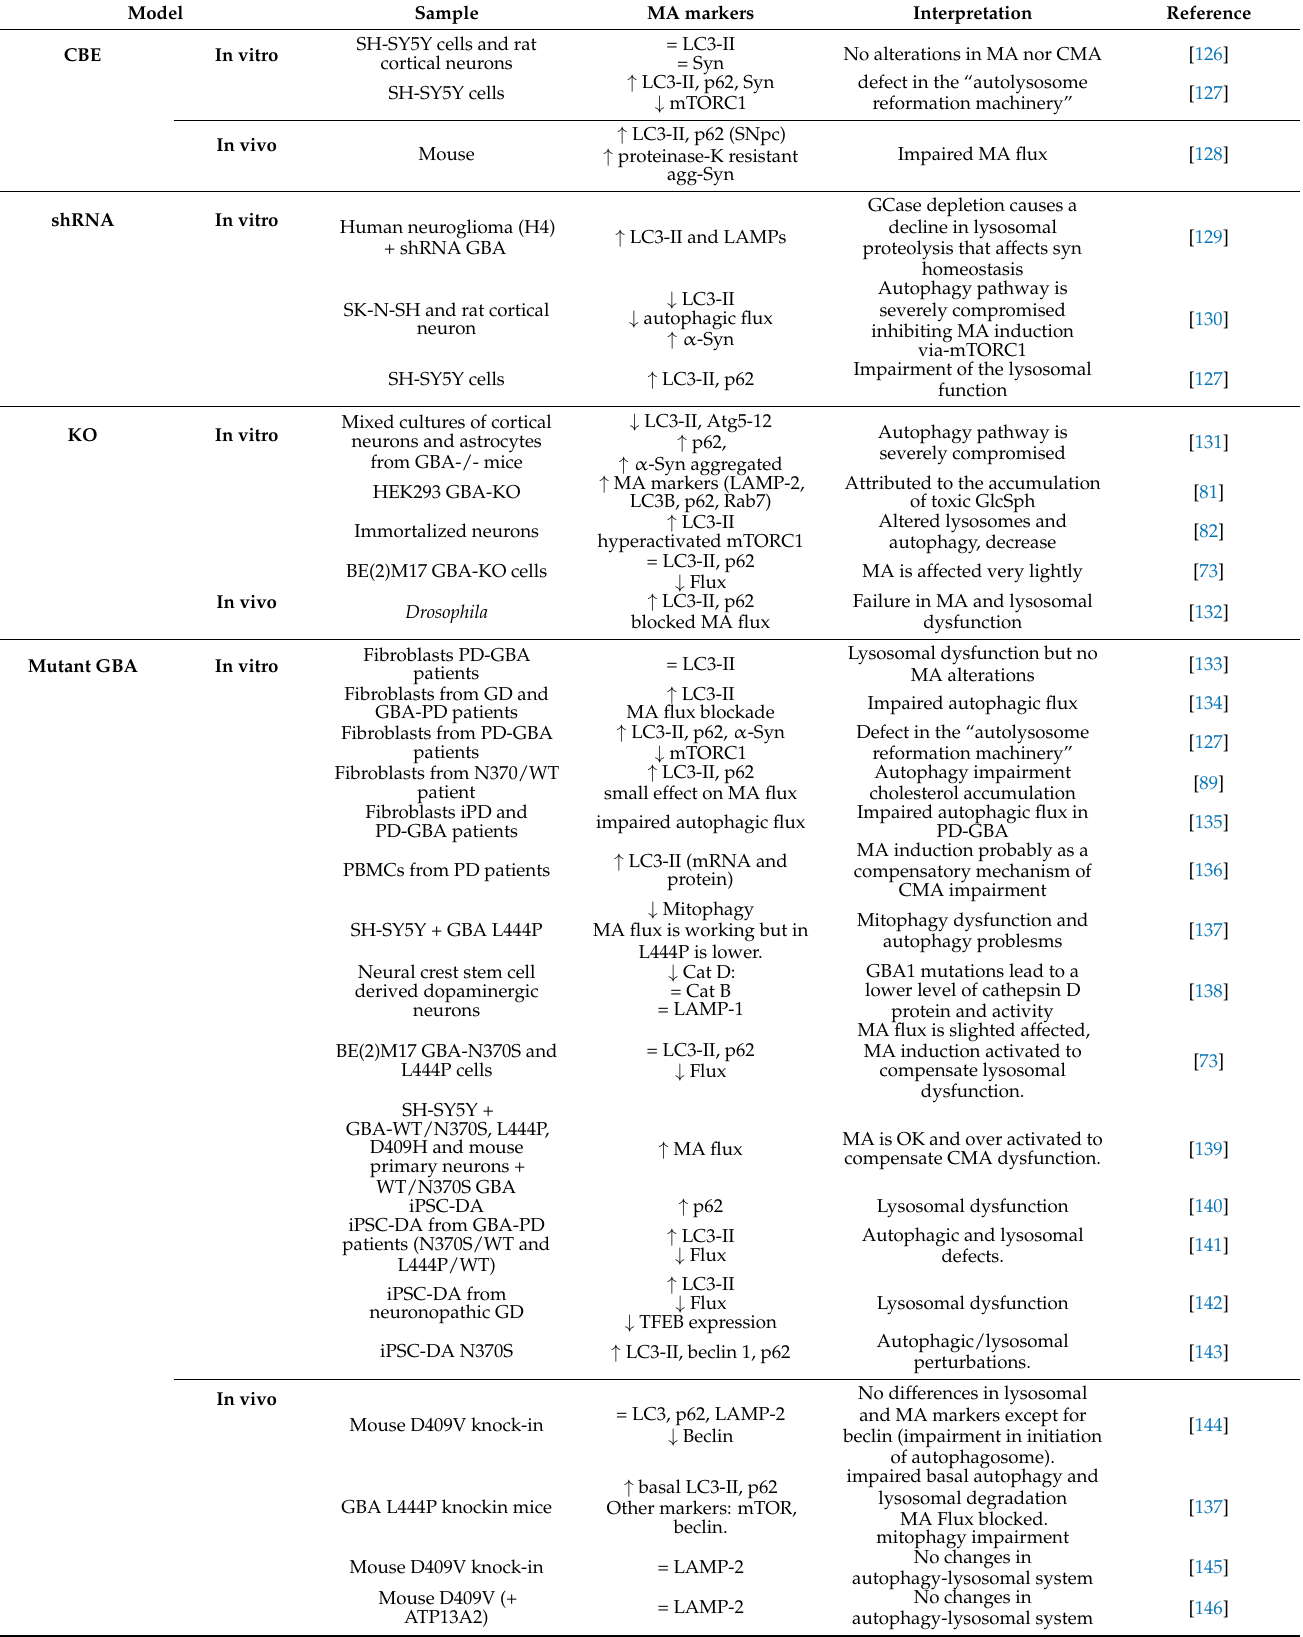
Table 1. Macroautophagy alteration in vitro and in vivo GBA